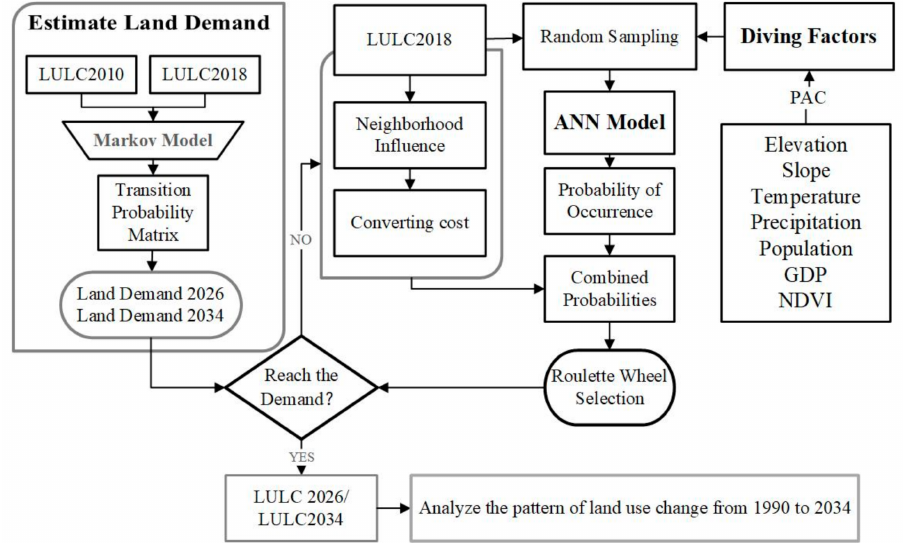
Figure 3. Methodological framework for land use spatial distribution simulation and trend